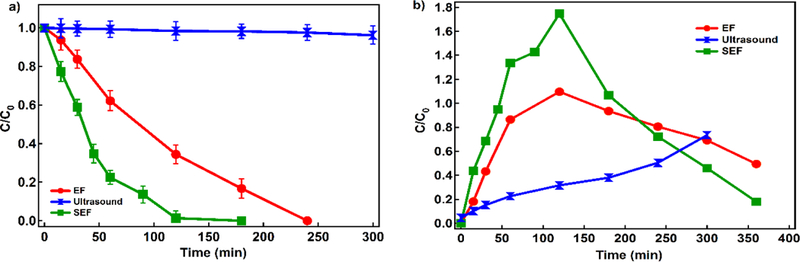
a) 4-CP and b) phenol decay during EF, US and SEF (Conditions: Fe2+: 80 ppm, current density: 16.94 mA cm−2, 10 mg L−1 Pd as Pd/Al2O3, Na2SO4: 10 mM, pH= 3, and 4-CP: 200 ppm)